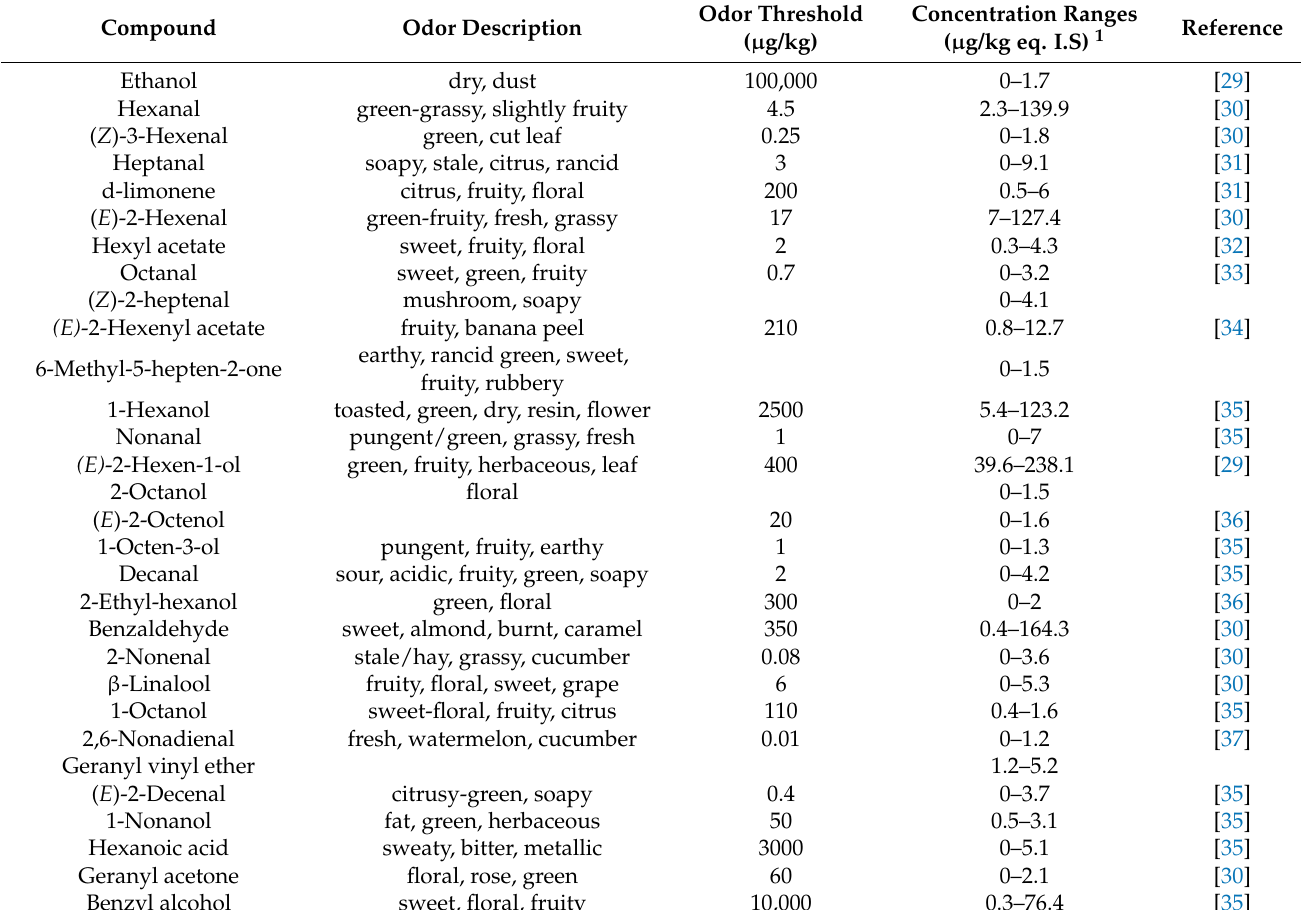
Table 2. Volatile compounds identified in Regina sweet cherries, their odor description, published odor threshold (with references) and concentration range found in the fruit at phenological stages 2 to 6 in cherries without